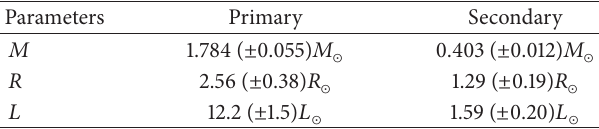
Table 4: Absolute parameters of the two components in V921